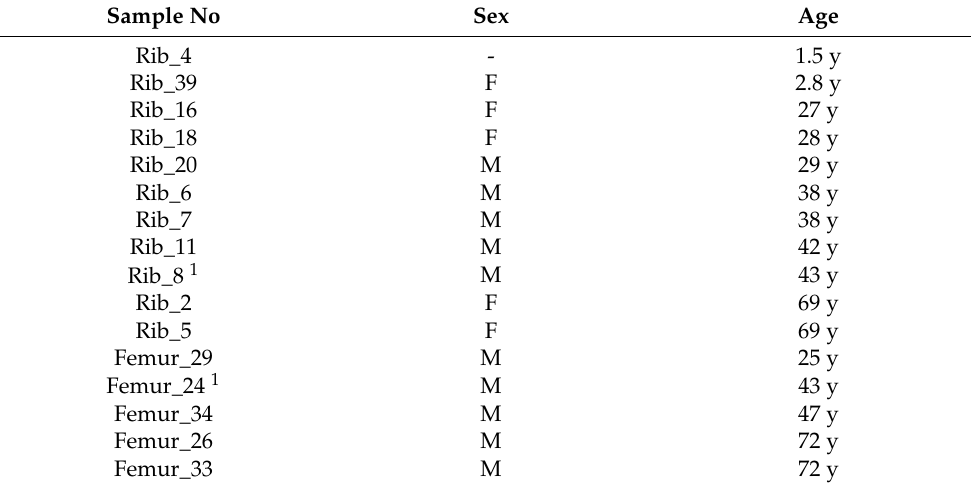
Table 1. Demographics of the Blackburn